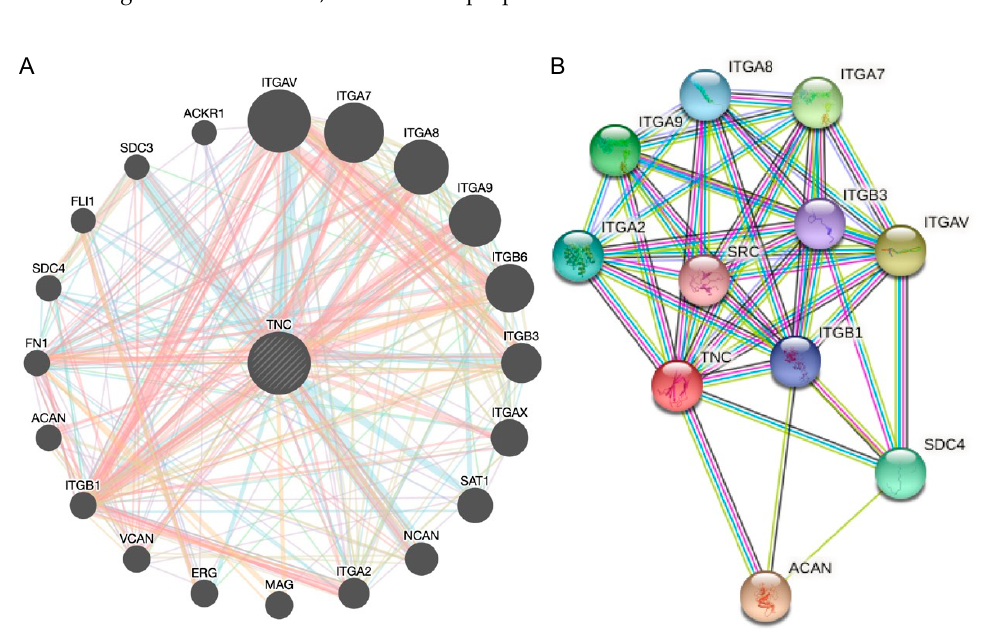
normal lung. HR: hazards ratio; TPM: transcripts per million.